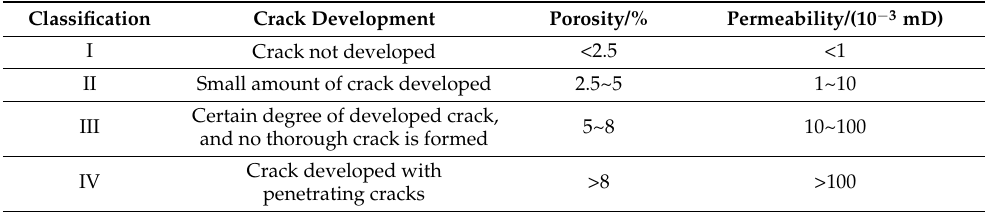
Table 3. Porosity and permeability characteristics classification of gas storage caprock of depleted oil and gas reservoir.